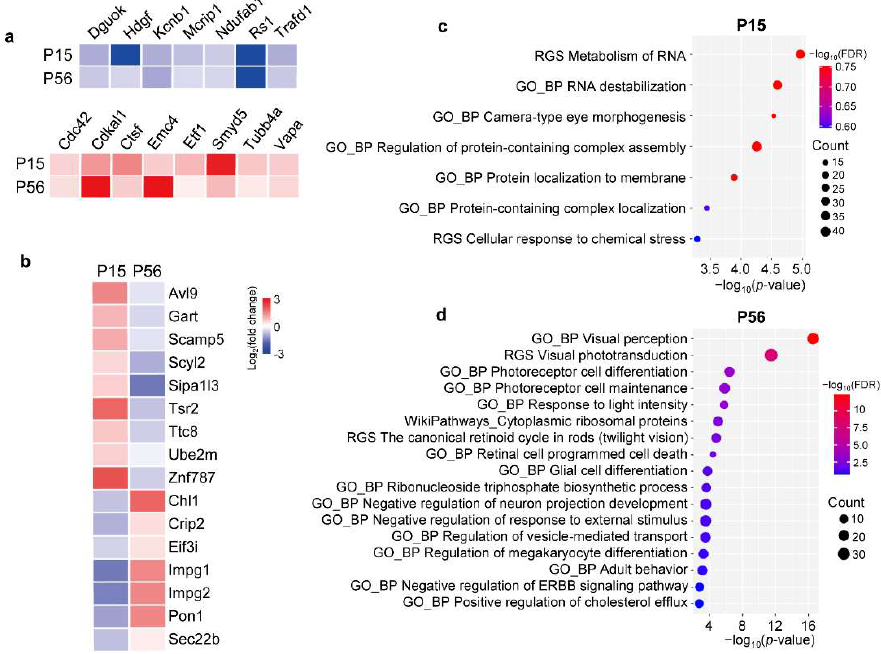
Figure 5. DEPs in RS1-KO retinas and their related functions. ( a , b ) Heatmap showing DEPs ( p -value < 0.05, 1.5-fold change) shared by P15 and P56. Fifteen proteins displayed the same regulated trend, including seven downregulated and eight upregulated proteins ( a ). Sixteen proteins showed contrasting expression trends in P15, compared with P56 ( b ); ( c , d ) Metascape enrichment results associated with DEPs in RS1-KO retinas at P15 ( c ) and P56 ( d ) compared to age-matched WT controls. DEP, differentially expressed protein; RGS, reactome gene sets; BP, biological process.